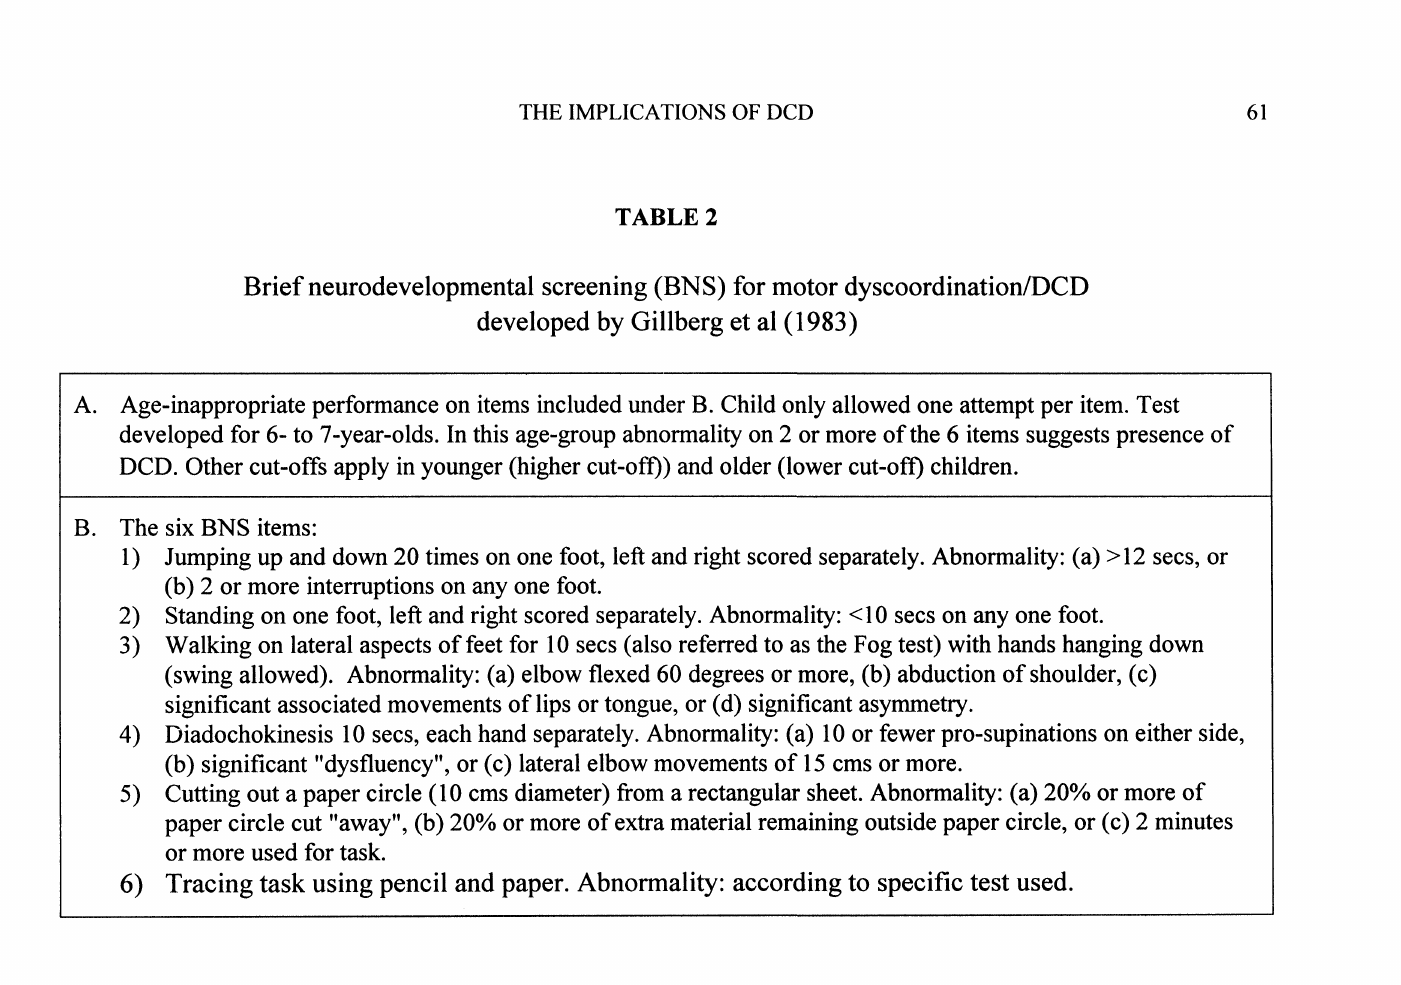
Brief neurodevelopmental screening (BNS) for motor